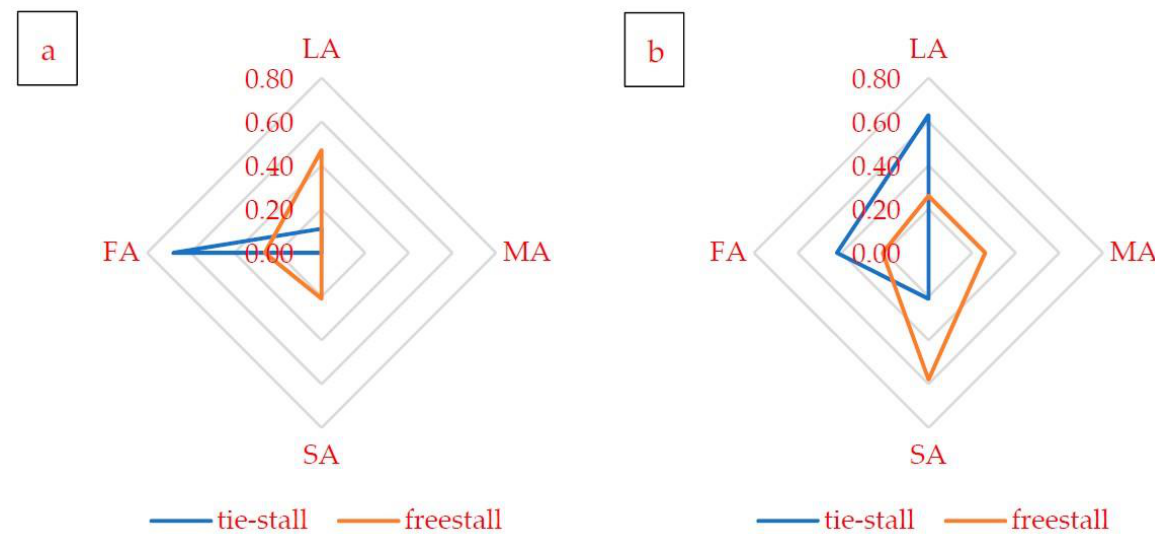
Figure 1. Average (calculated) amount of damage ( a ) and design errors ( b ) per one barn and each zone, including: lying area (LA), milking area (MA), social area (SA) and feeding area (FA), for barns with tie-stall and freestall housing system.